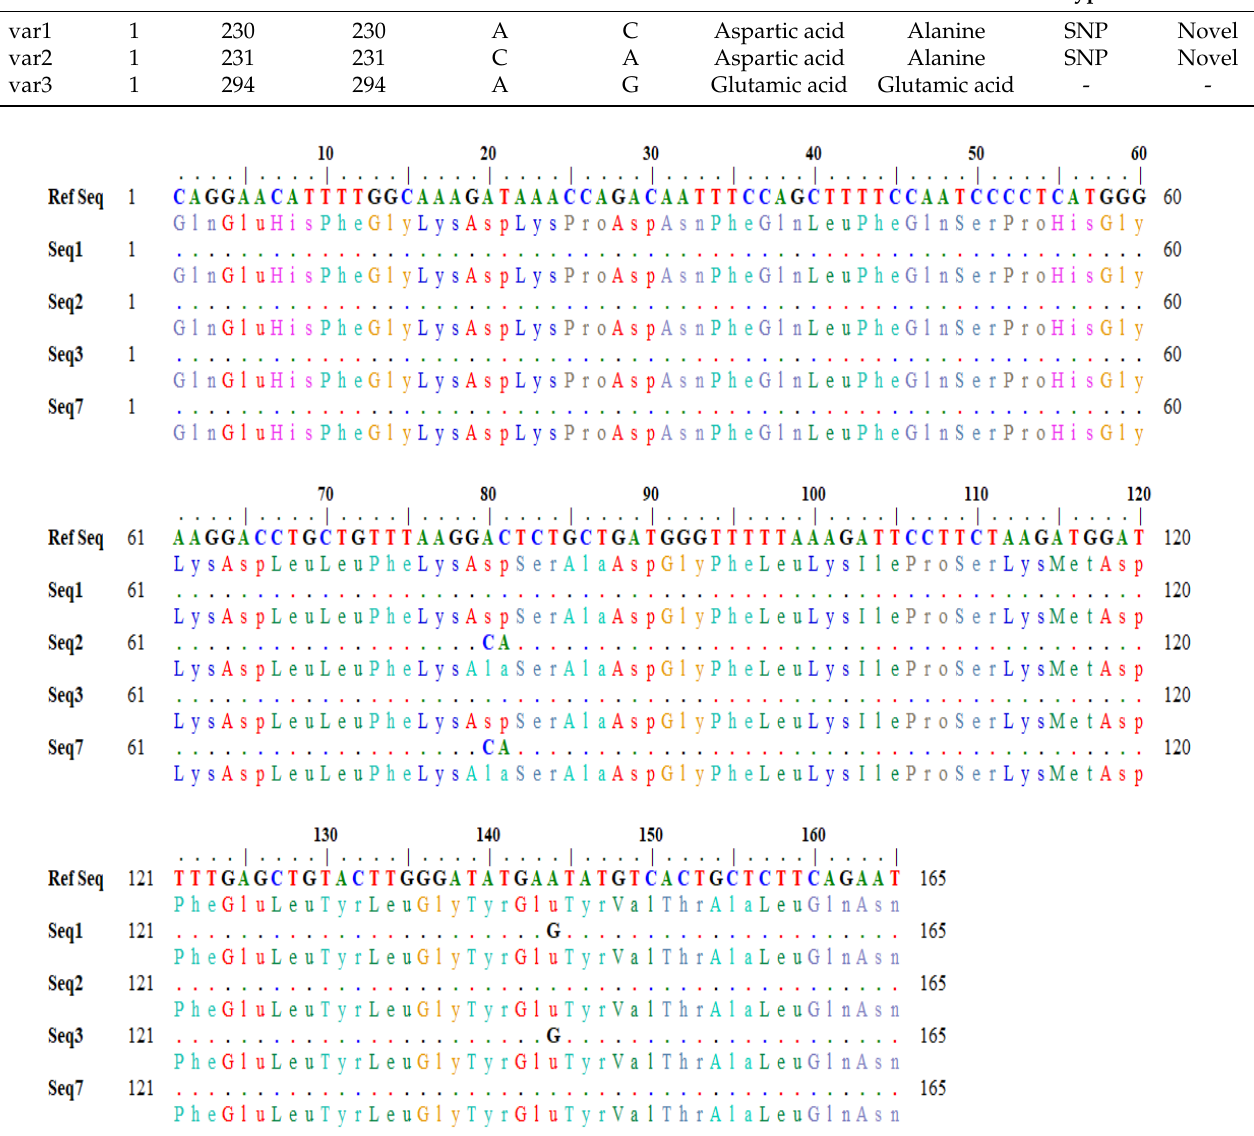
Figure 2. Detailed output of codons showing variations.